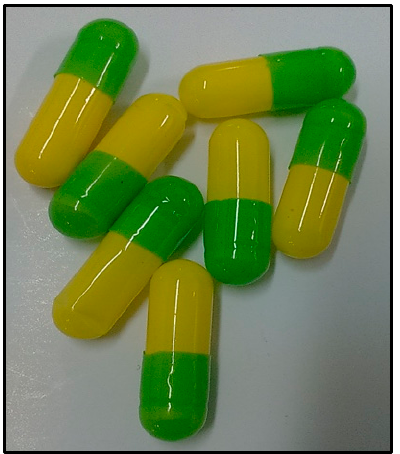
Figure 3. Hard-shell capsules produced from goatskin gelatin .